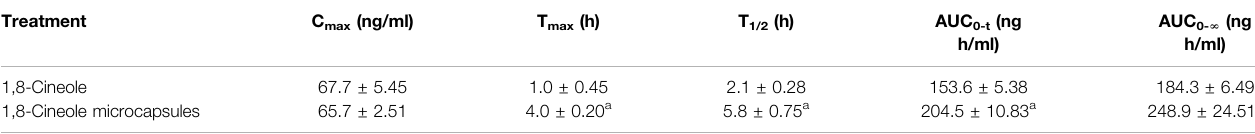
TABLE 1 | Pharmacokinetic parameters of 1,8-cineole in chicken after oral administration of 1,8-cineole and 1,8-cineole microcapsules. Treatment